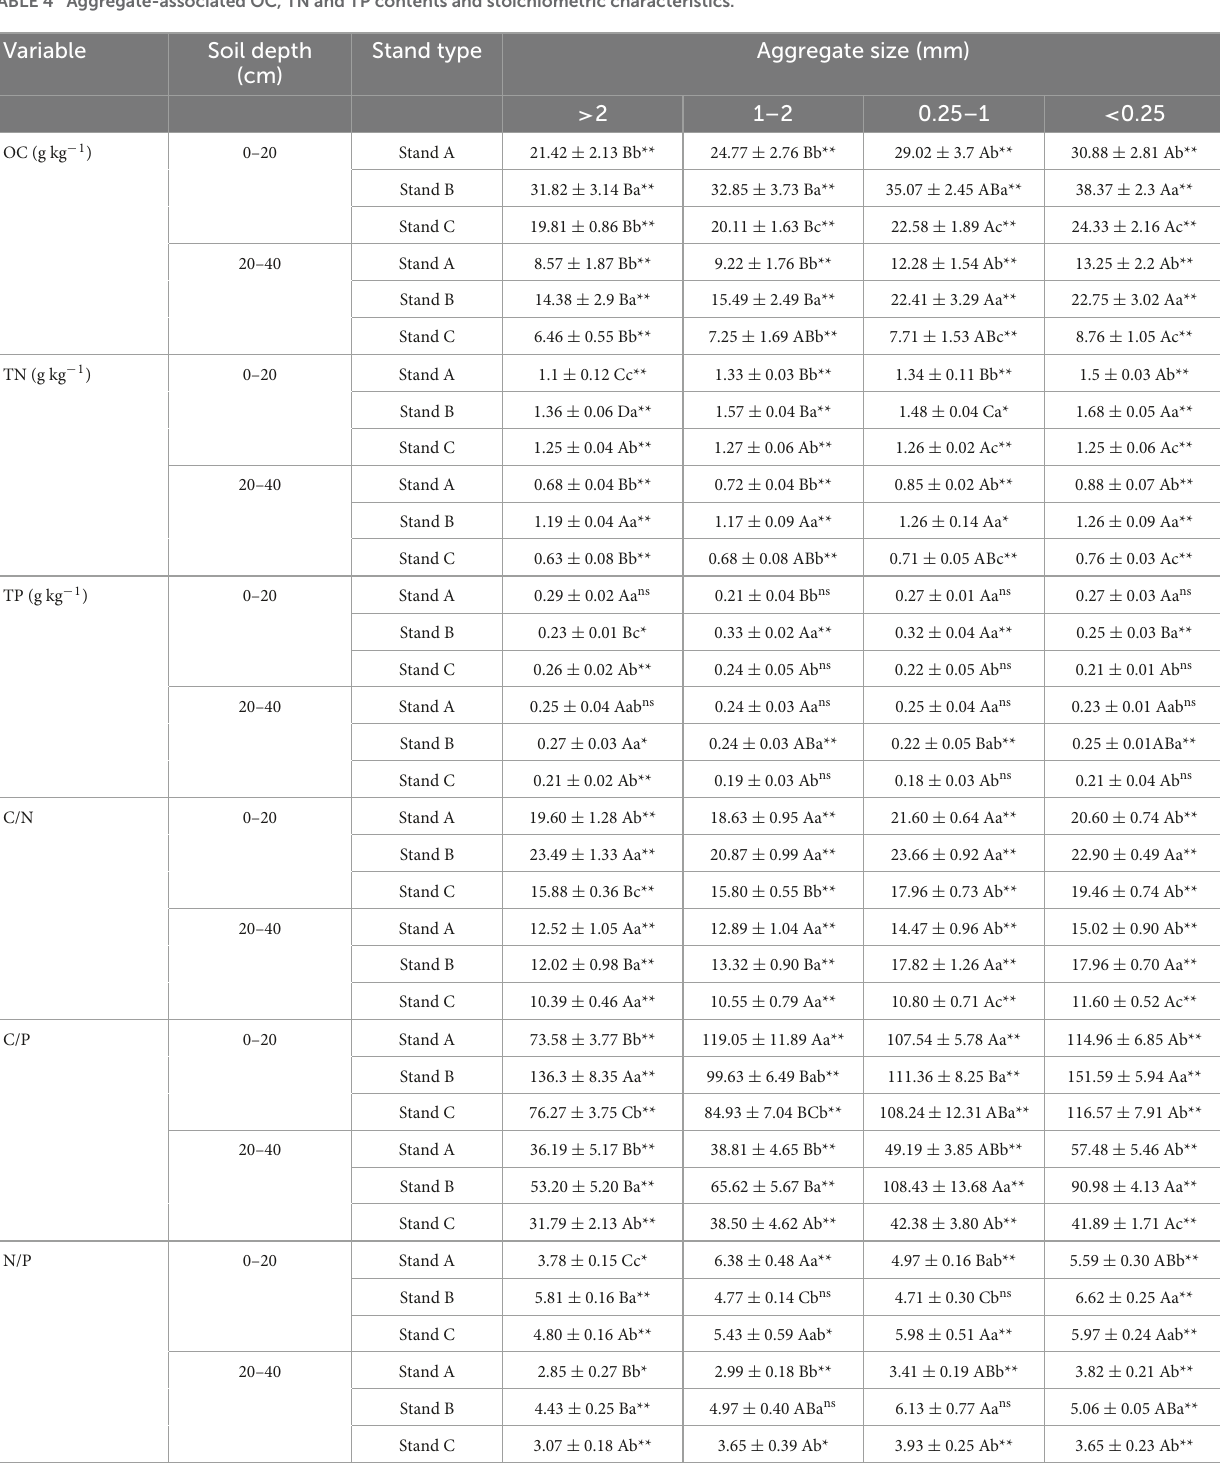
TABLE 4 Aggregate-associated OC, TN and TP contents and stoichiometric characteristics. Variable Soil depth